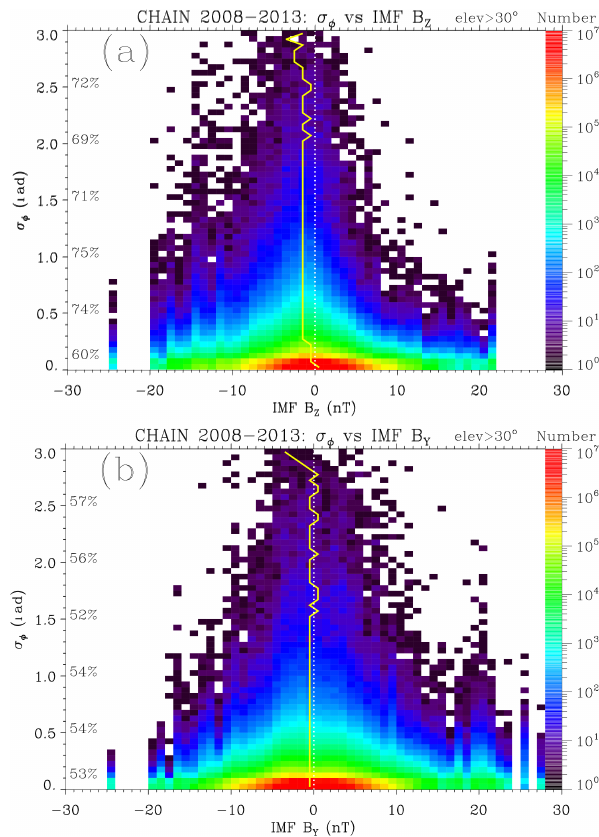
Figure 7. The phase scintillation occurrence dependence on the IMF (a) B Z and (b) B Y . The percentages of negative B Z or B Y values for σ (cid:56) exceeding given thresholds are shown on the left. The centers of Gaussian fits to distributions of occurrence number as a function of B Z or B Y for each σ (cid:56) interval are shown by the yellow